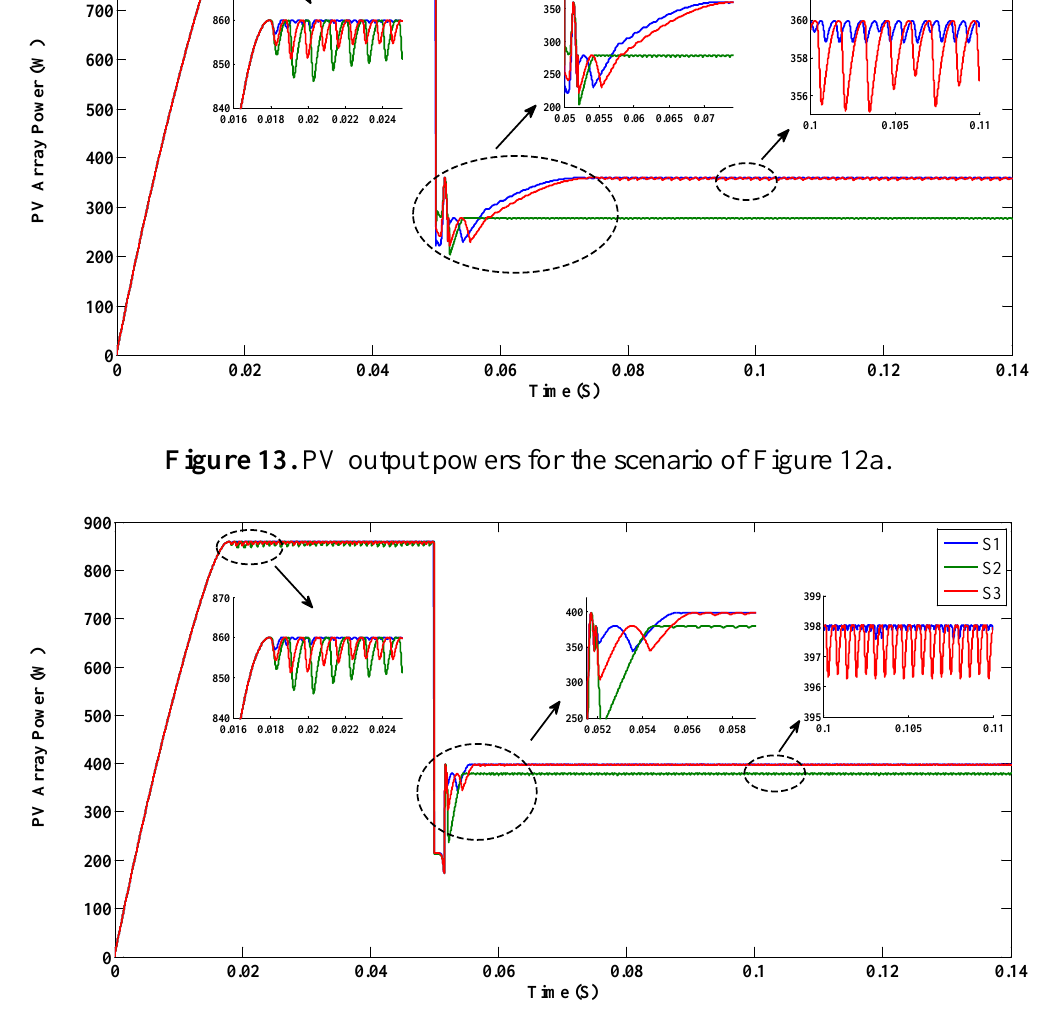
Figure 14. The PV output power for the scenario depicted in Figure